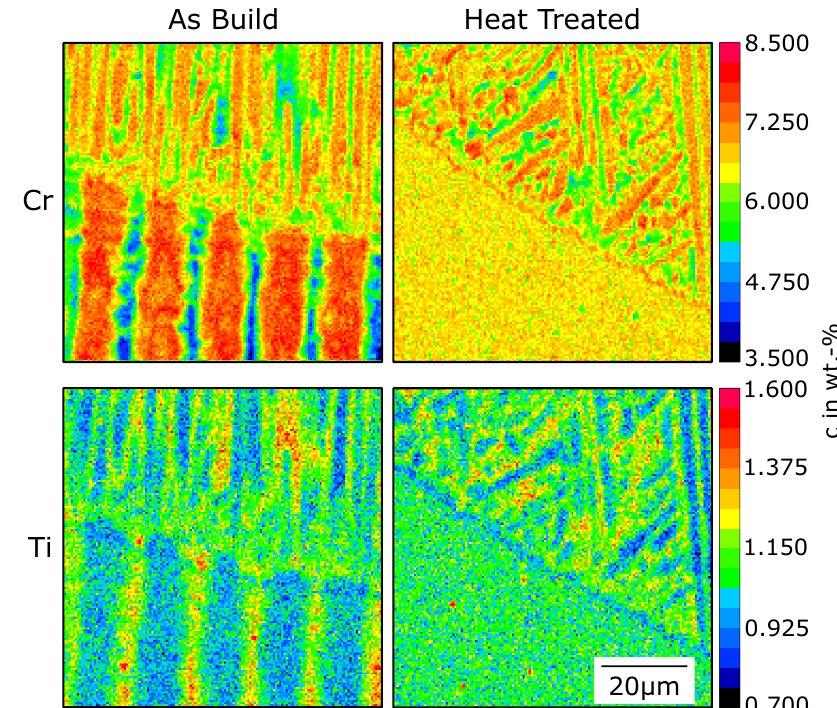
Figure 4. The concentrations of Cr and Ti for the as-built and heat-treated samples at the melt-pool border. The resolution of the concentration maps (0.5µm) is additionally constrained by the micro probe measurement. For the given measurements, the effective resolution is in a range above 0.75µm. Thus, the minimum and maximum values, especially for the fine microstructures in the melt pool, are lost due to